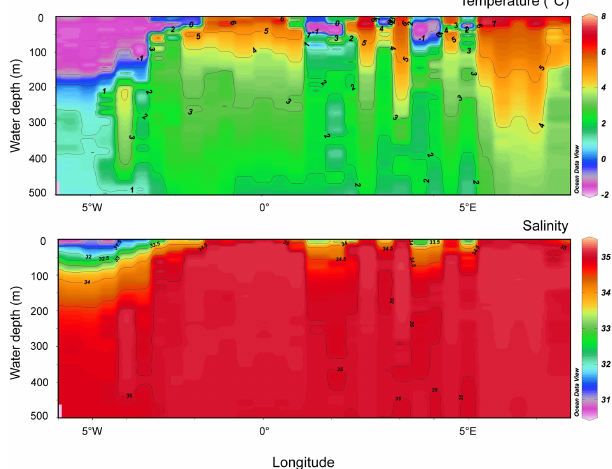
Figure 2. Temperature and salinity of the water column in the up- per 500m along a transect at 78 ◦ 50 (cid:48) N across the Fram Strait. Data obtained by conductivity–temperature–density (CTD) measure- ments during the expedition ARK-XXVI/1 (Beszczynska-Möller and Wisotzki, 2012). The figure comprises data obtained from 30 CTD stations, equally distributed along the